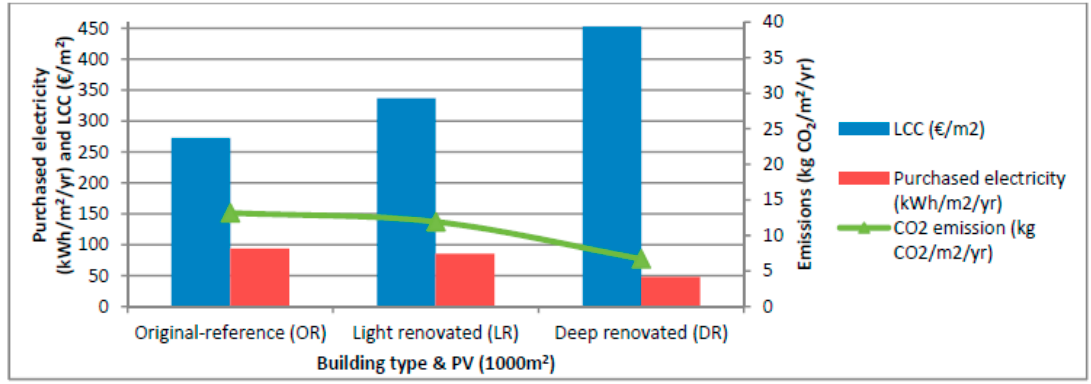
Figure 9. The annual purchased electricity, LCC, and CO 2 emissions from the centralized community-level PV and GSHP-based energy system integrated with old residential buildings (Case 1, PV + GSHP).